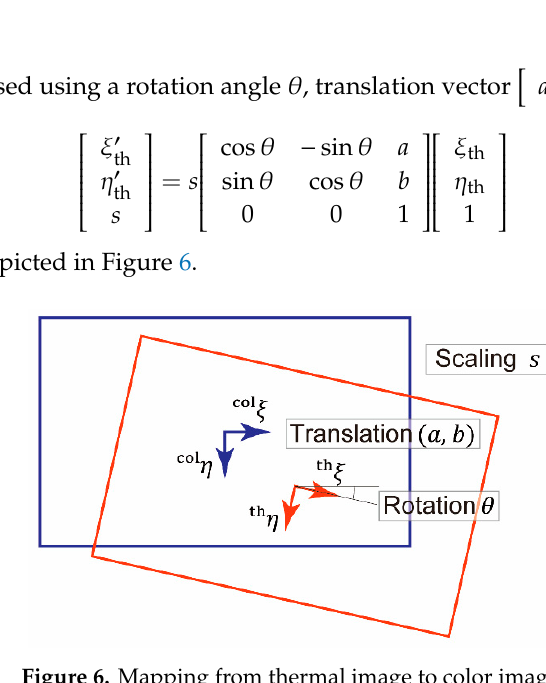
Figure 6. Mapping from thermal image to color image.